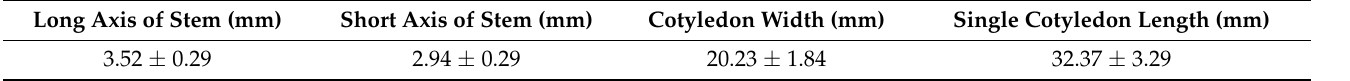
Figure 8. Rootstock seedlings: ( a ) rootstock seedlings in a greenhouse; ( b ) structure of single rootstock seedling. Table 1. Characteristic parameters of